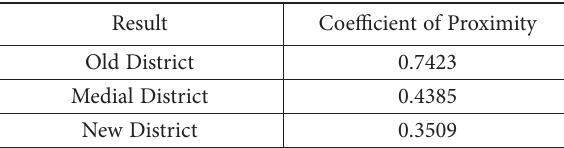
Table 11. Ranking districts in terms of